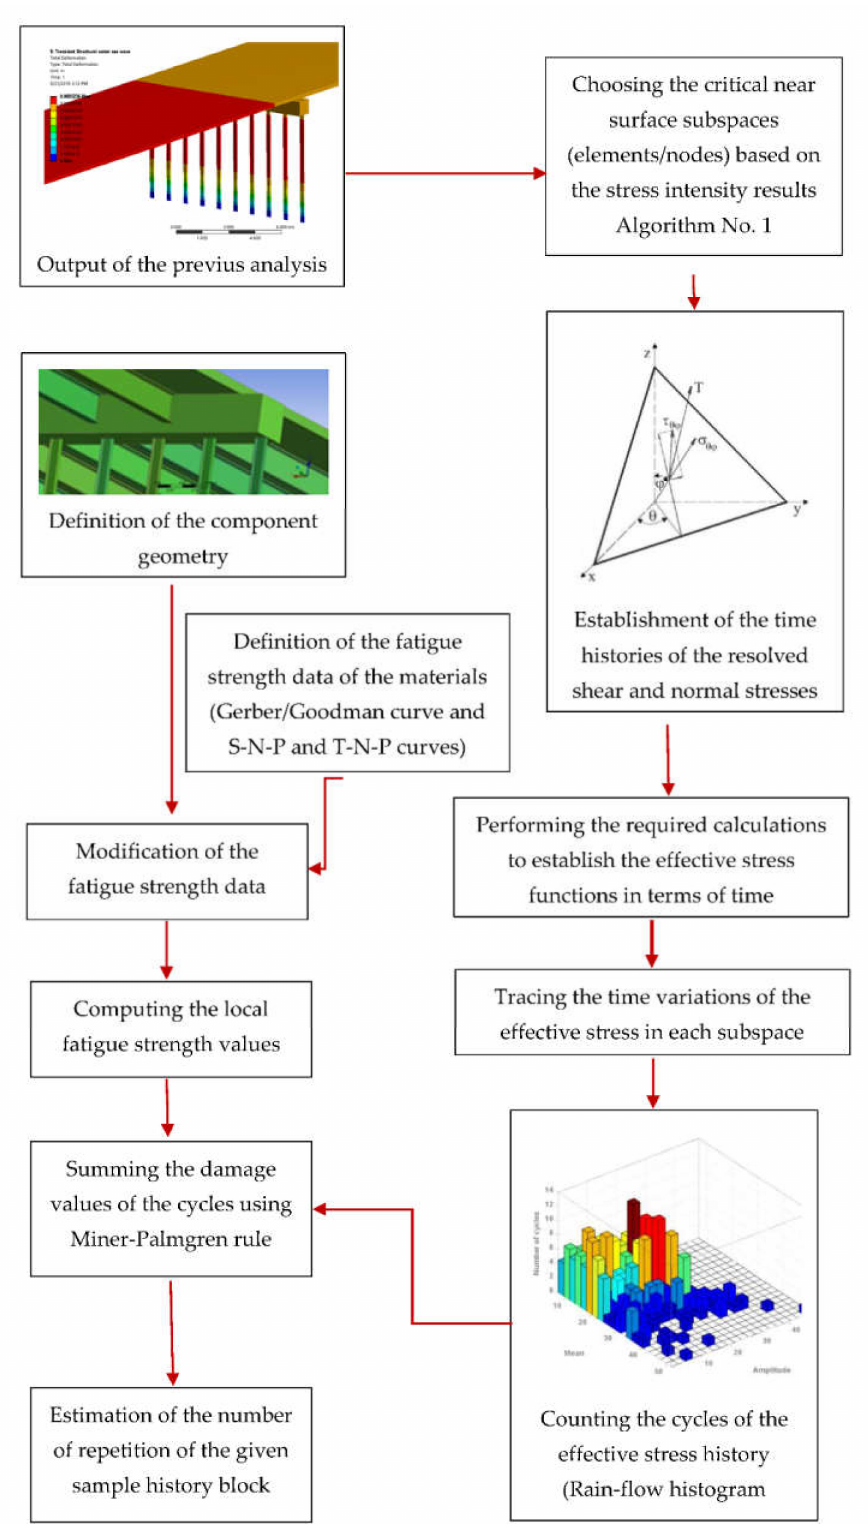
Figure 2. General schematic of the fatigue life estimation process used in this